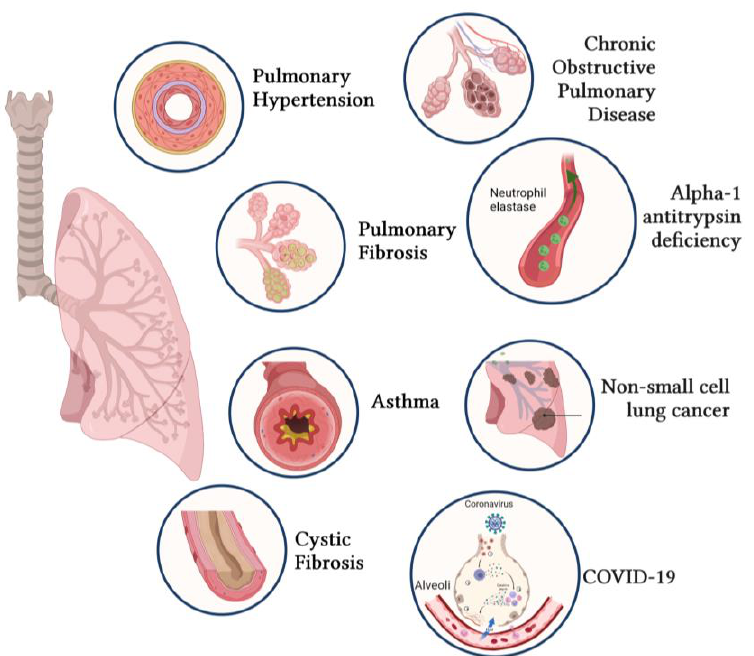
Figure 1. Common respiratory diseases associated with genetic disorders or molecular alterations. Over the past decades, progress in molecular profiling has provided critical insights into the genetic profile of patients with respiratory diseases, such as pulmonary arterial hypertension, pulmonary fibrosis, asthma, cystic fibrosis, chronic obstructive pulmonary disease, alpha-1 antitrypsin deficiency, non-small-cell lung cancer, and COVID-19. Here, we display schematic representations of the main pathological features of the diseases mentioned above, including vascular remodeling, mucus gland hyperplasia, inflammatory cell infiltrates, bronchial smooth muscle hypertrophy, fibrosis, emphysema, and tumor formation. Created with BioRender.com (accessed on 3 March 2022). In this review, we will review (1) different types of viral and non-viral vectors as well as gene-editing techniques that are currently being used in respiratory diseases; and (2)